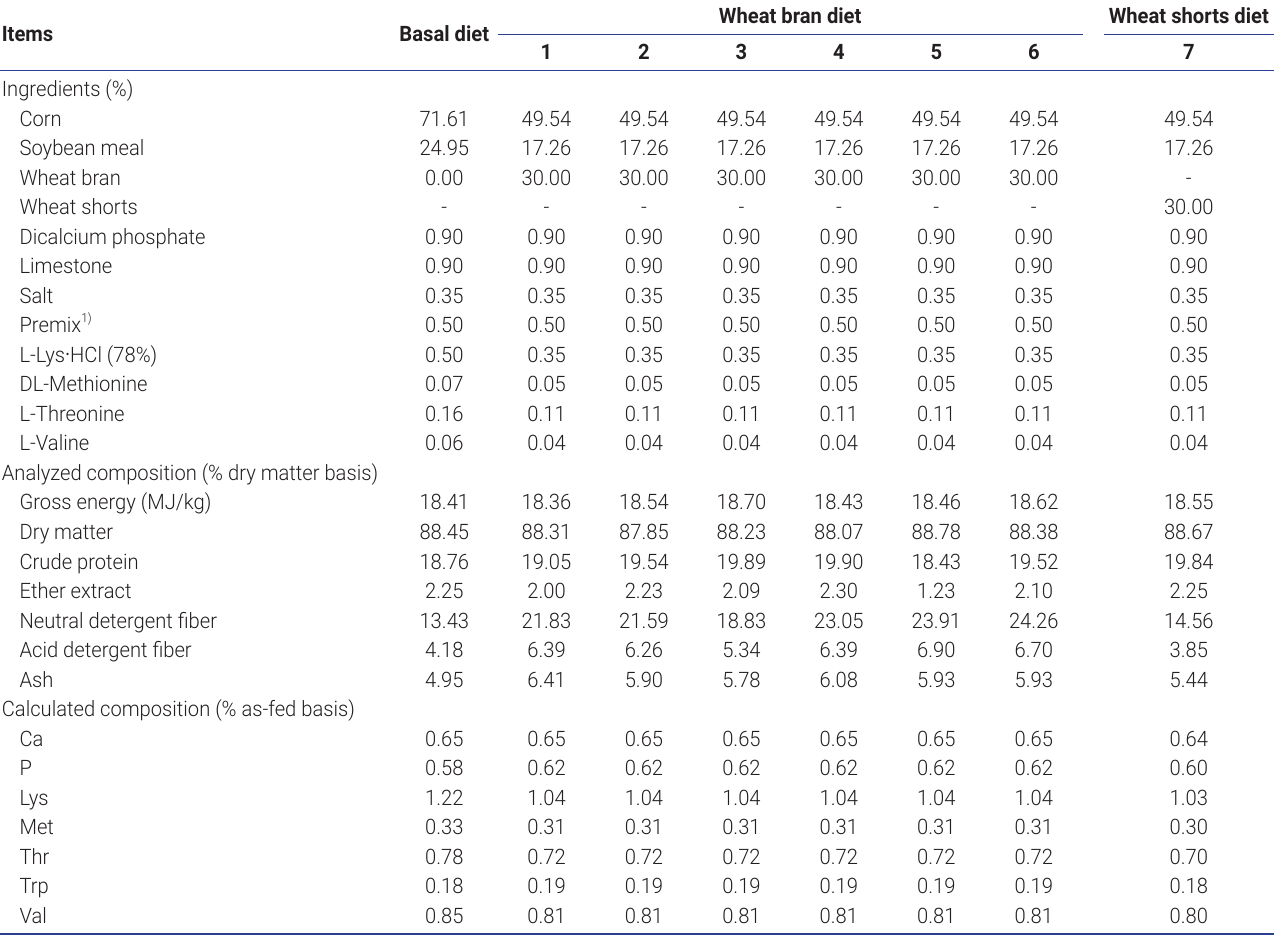
Table 2. Ingredient composition and chemical composition of experiment